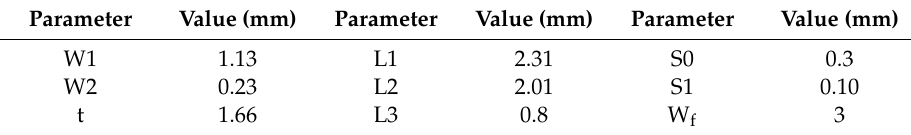
Table 3. Di ff erent parameters of the filter and their values at 3.5 Table 3. Different parameters of the filter and their values at 3.5 GHz.